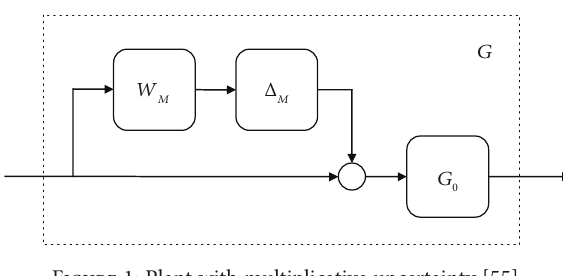
Figure 1: Plant with multiplicative uncertainty